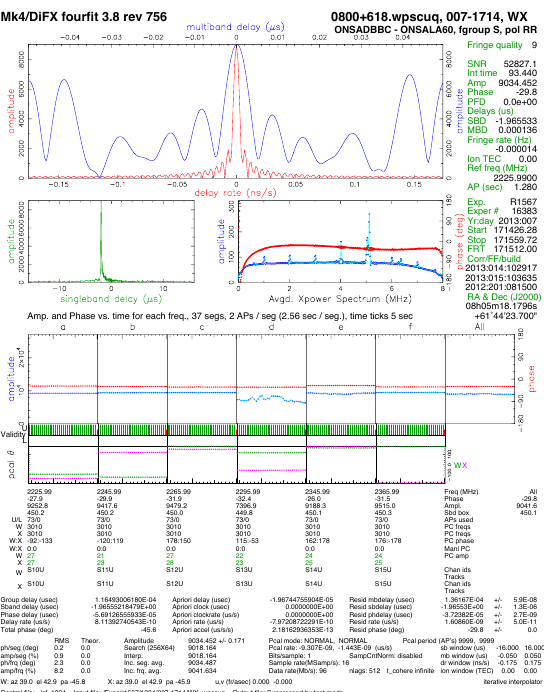
Figure 2: Fringe plot on S-band for the session R1.567 zero-baseline test done with DiFX. The station names, ONSADBBC and ONSALA60, correspond to Od an On, respectively.